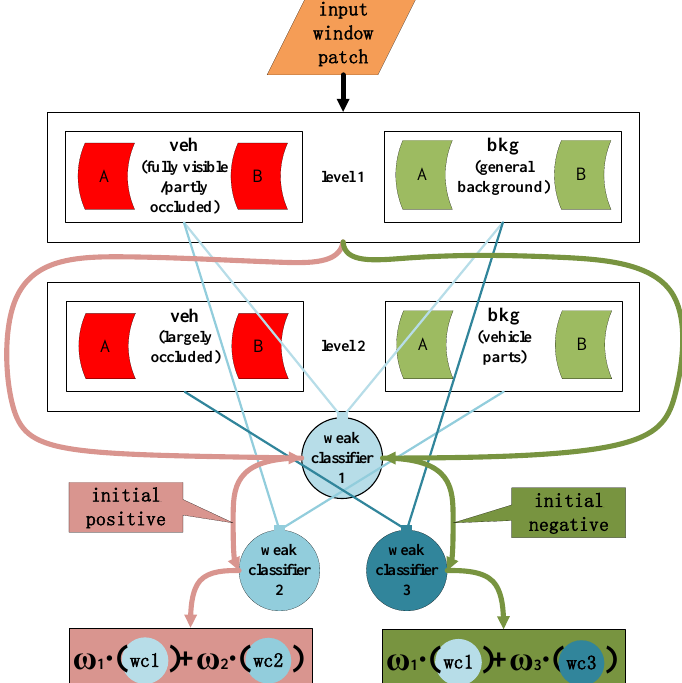
Figure 7. Illustration of downstream AdaBoost classification process in CESDD. An input window patch is initially represented by Level 1 SDDs and classified by corresponding weak classifiers to gen- erate initial classification, and then, based on the initial classification result, selectively represented by SDDs in Level 2 and accordingly selectively classified by the rest weak classifiers; at last, classifications of activated weak classifiers are aggregated by learned weights to produce final